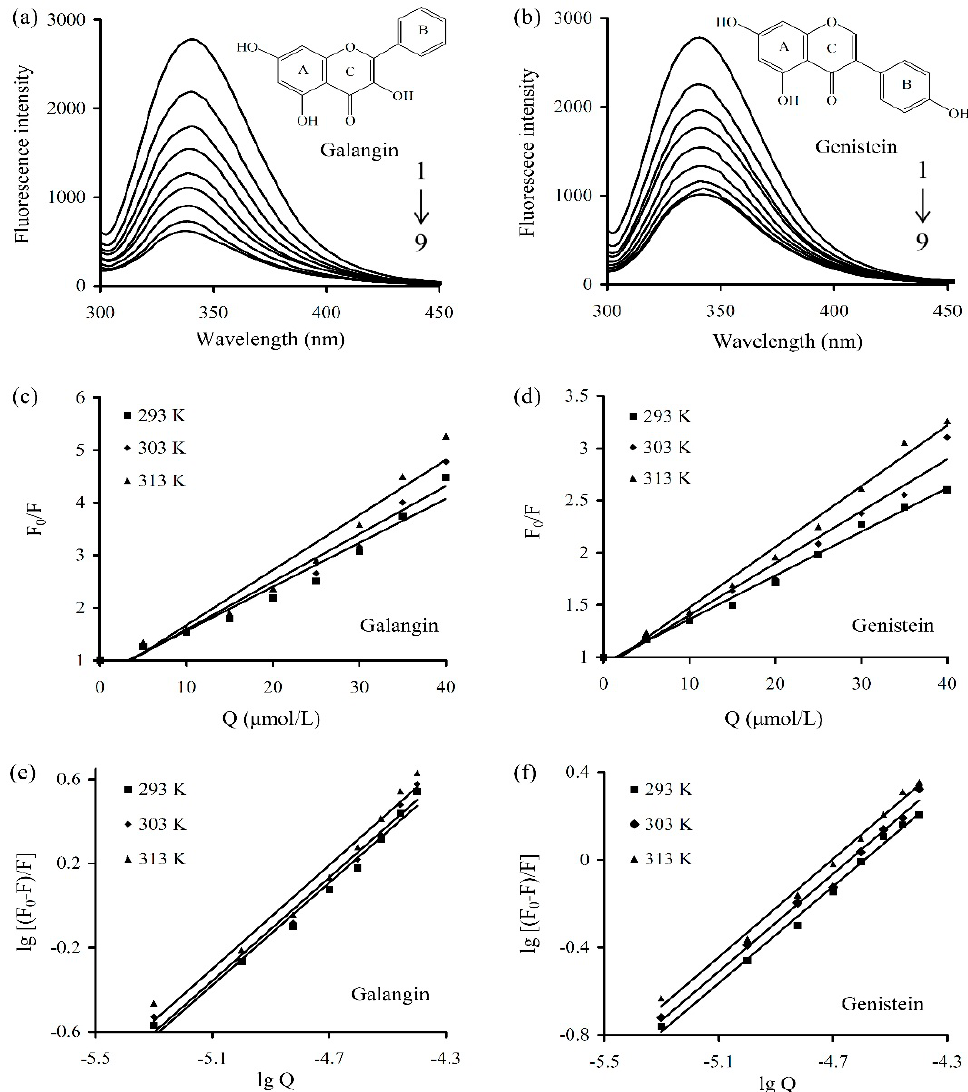
Figure 1. The fluorescence spectrum (300–450 nm) of whey protein isolate (WPI) solution with or without galangin ( a ) and genistein ( b ) at 293 K, the Stern ‐ Volmer plots for galangin ( c ) or genistein ( d ), as well as the lg[(F0 − F)/F] vs. lgQ plots for the binding of galangin ( e ) or genistein ( f ) with WPI at the three temperatures. WPI was used at 20 μ mol/L, while galangin/genistein was used at 0, 5, 10, 15, 20, 25, 30, 35, and 40 μ mol/L (from 1 to 9).